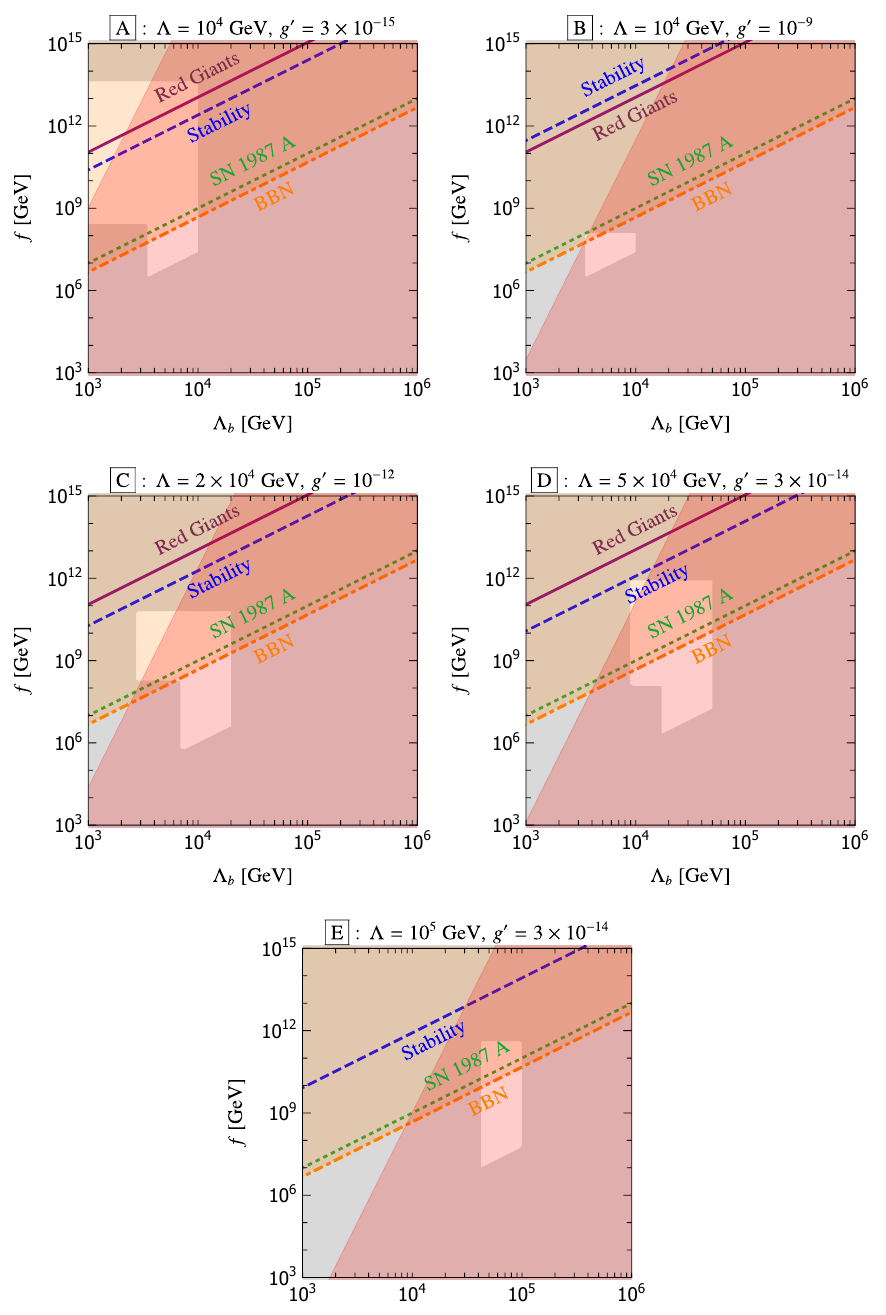
Figure 8 . Case of relaxation AFTER in(cid:13)ation with EW gauge boson production as described in section 4.1. Pale regions were the allowed region derived in ref. [4] without including the e(cid:11)ect of relaxion fragmentation. The red region is the new exclusion due to relaxion fragmentation, which rules out everything under the assumption that the relaxion dominates the energy density of the universe during relaxation (eq. 4.31).